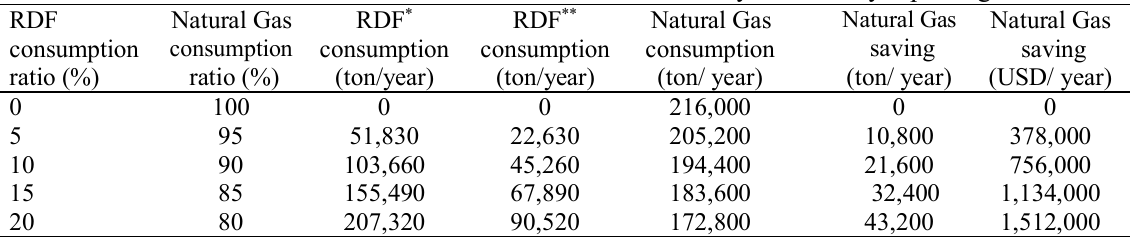
Table 4. The annual amount of Natural Gas numerical and currency reserves by replacing with RDF RDF